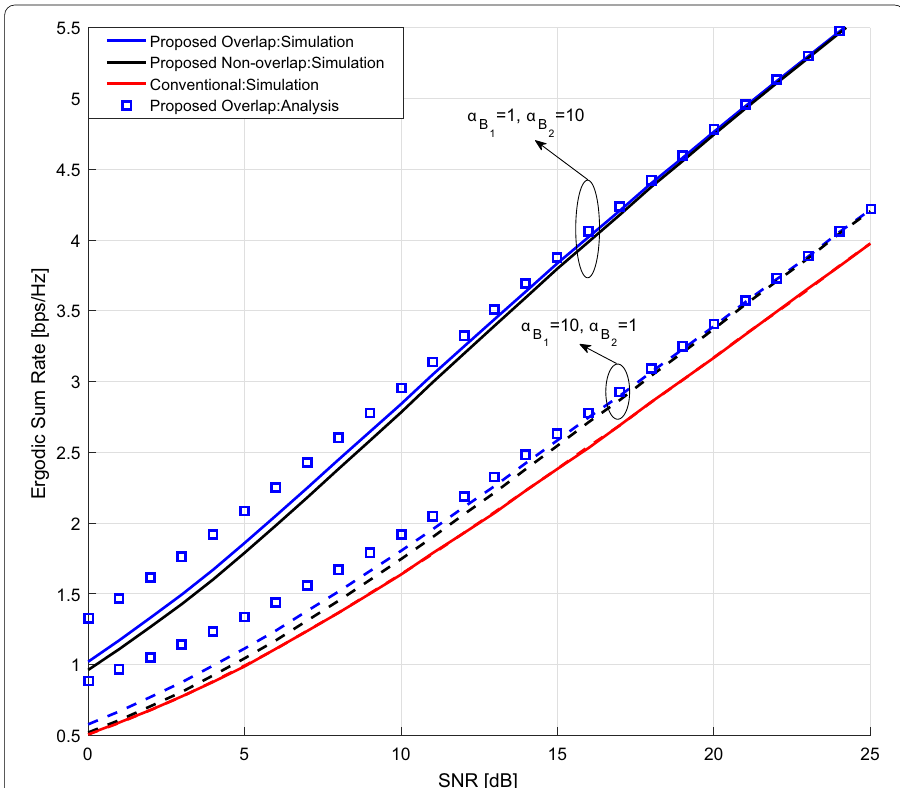
Fig. 2 The ergidic SR for our proposed NOMA-IoV system including overlap and non-overlap cases compared with conventional NOMA scheme versus the transmit